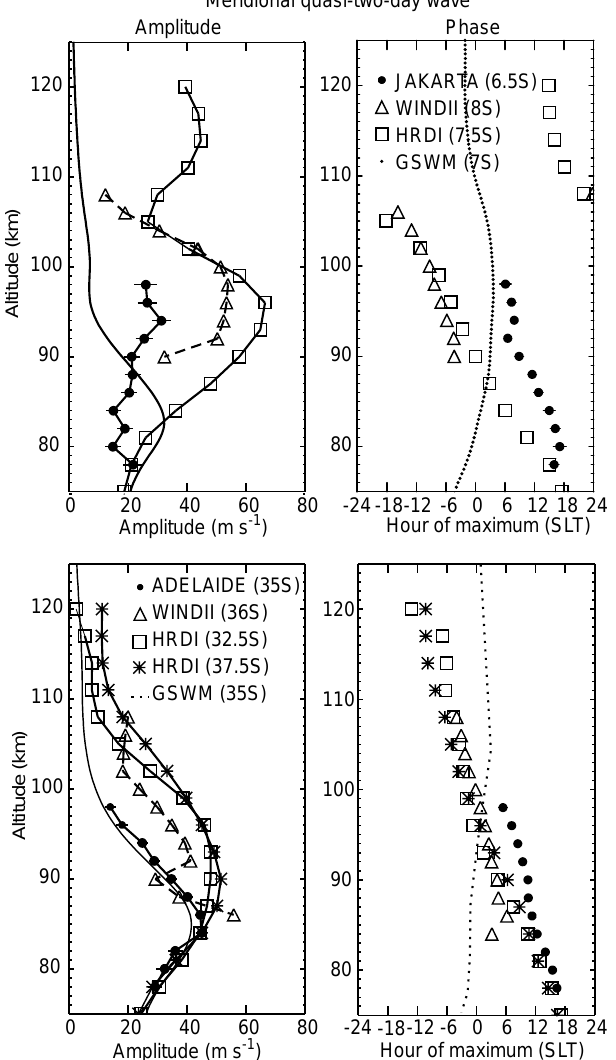
Fig. 15. The vertical structure of the meridional quasi-two-day wave near Jakarta ( top ) at 6.5 (cid:14) S and Adelaide ( bottom ) at 35 (cid:14) S. The amplitude ( left ) and phase ( right ) are estimated from fits to a period of